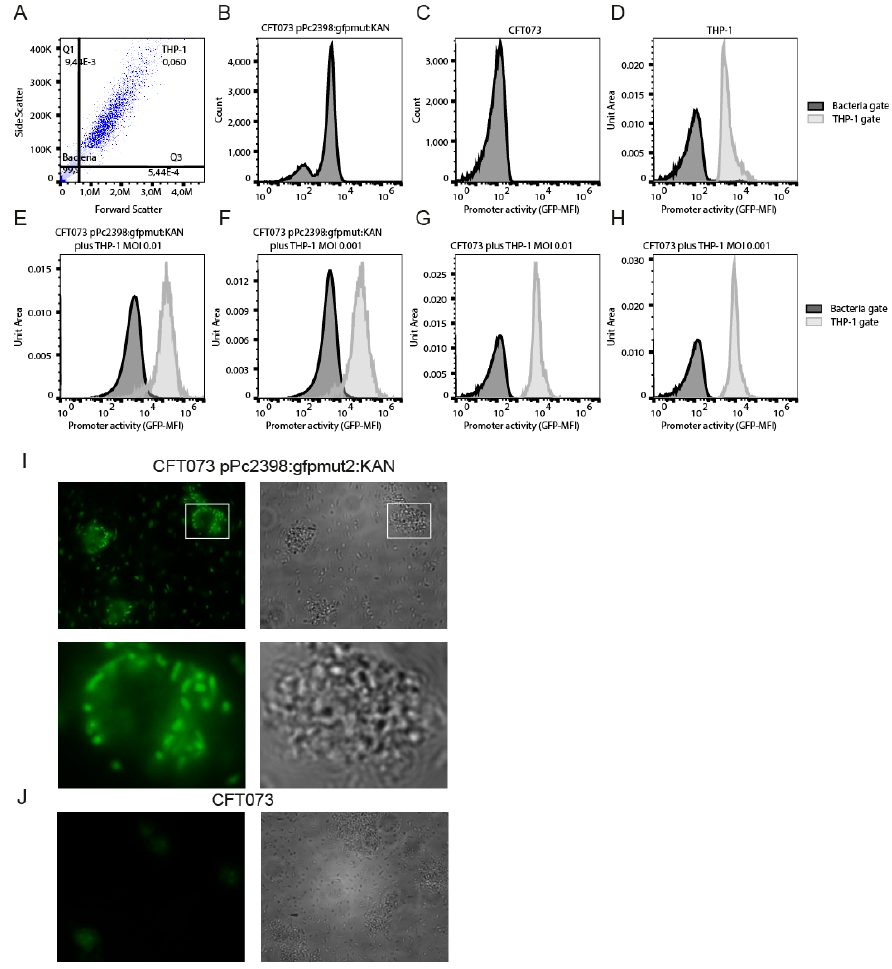
Figure 4. CFT073 in close association with THP-1 cells activate P2 most intensively. We co-cultured CFT073 pPc2398:gfpmut:KAN and monocytic THP-1 cells in RPMI-1640 medium and defined by forward and side scatter the bacterial (( A ), lower left quadrant: Bacteria) and cellular gate (( A ), upper right quadrant: THP-1). ( B ) displays just CFT073 pPc2398:gfpmut:KAN (5 × 10 3 bacteria/well), ( C ) just CFT073 (5 × 10 3 bacteria/well) and ( D ) just monocytic THP-1 cells (5 × 10 5 cells/well), which were used as controls. In parallel we co-cultured monocytic THP-1 cells (5 × 10 5 cells/well) with CFT073 pPc2398:gfpmut:KAN (MOI = 0.01 or 0.001, ( A , E , F )) or with CFT073 (MOI = 0.01 or 0.001, ( G , H )) as indicated. We determined P2 promoter activity by flow cytometry after 24 h. Using the bacteria and THP-1 gate as defined in ( A ) we determined THP-1-non-associated (dark gray) and THP-1-associated bacteria (light gray). The dark gray area in ( D ) represents cellular debris of THP-1 cells. We modified the experiment described above and co-cultured monocytic THP-1 cells (5 × 10 5 cells/well) with CFT073 pPc2398:gfpmut:KAN (MOI = 0.001, ( I )) or with CFT073 (MOI = 0.001, ( J )), as indicated. After 24 h of culture, we removed most of the bacteria by centrifugation and added gentamicin (400 µg/mL) for another 3 h to further reduce extracellular bacteria. We then monitored P2 promoter activity of cell-associated or non-associated bacteria by fluorescence microscopy (( I , J ) left panels). White rectangles mark zoomed insets. Corresponding phase contrast pictures are also shown (( I , J ), right panels).